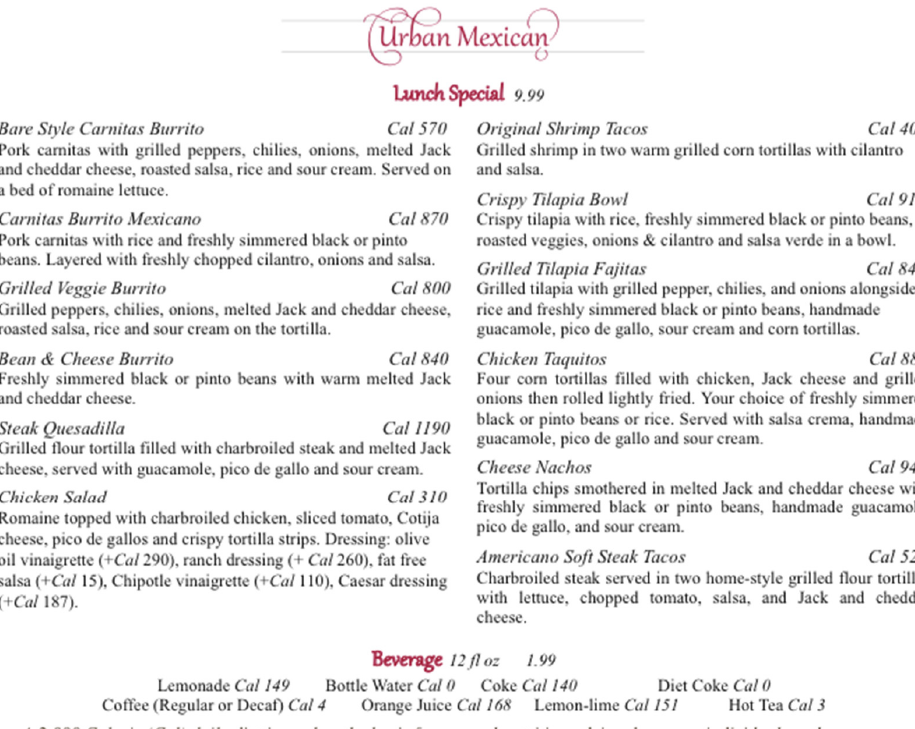
Figure A11. Urban Mexican Sweet Spot Menu.